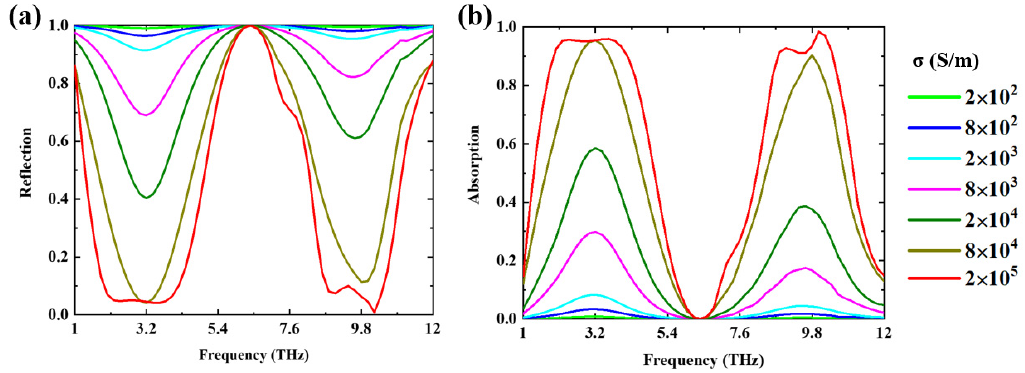
Figure 3. ( a ) Reflection and ( b ) absorption spectra with different conductivity of VO 2 .